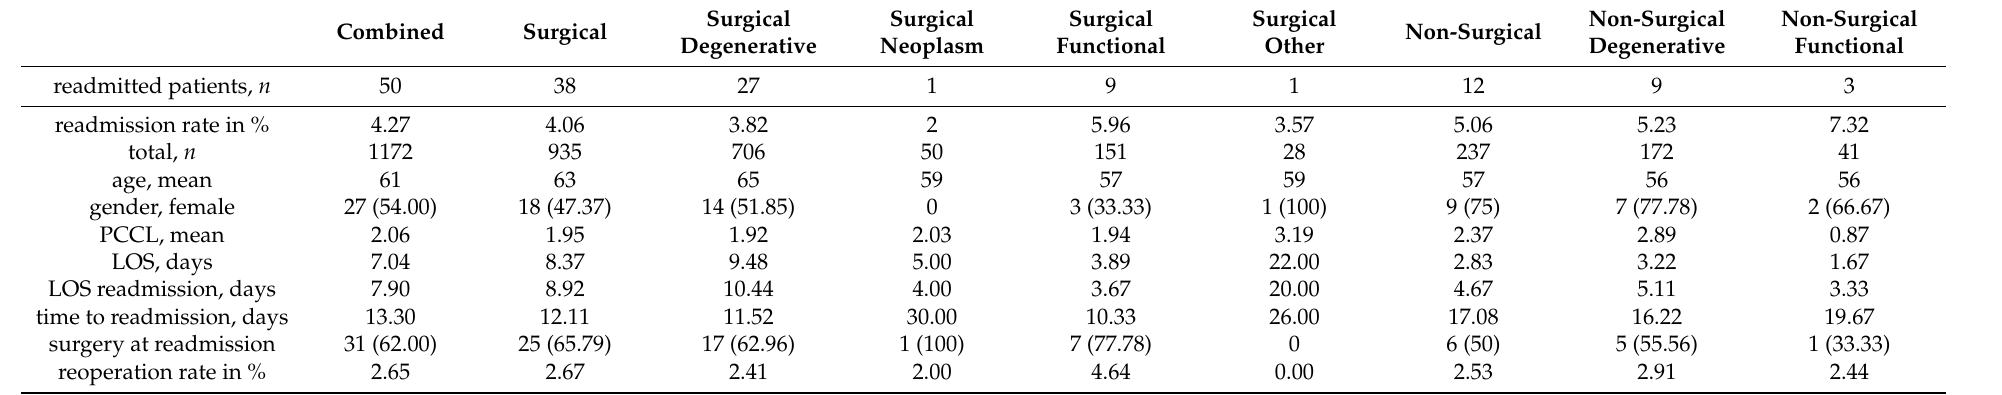
LOS, length of stay; n , number; PCCL, patient clinical complexity